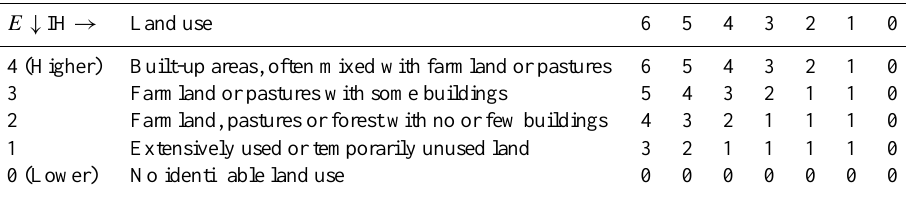
Table 2. Risk indicator R : combination of the impact hazard indicator IH (see Sect. 4.1) and the exposure indicator E with scoring scheme for E as a function of land use.